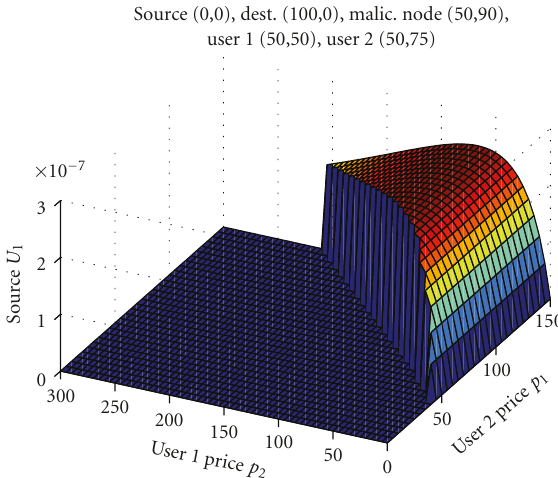
Figure 5: U 1 versus the prices of both